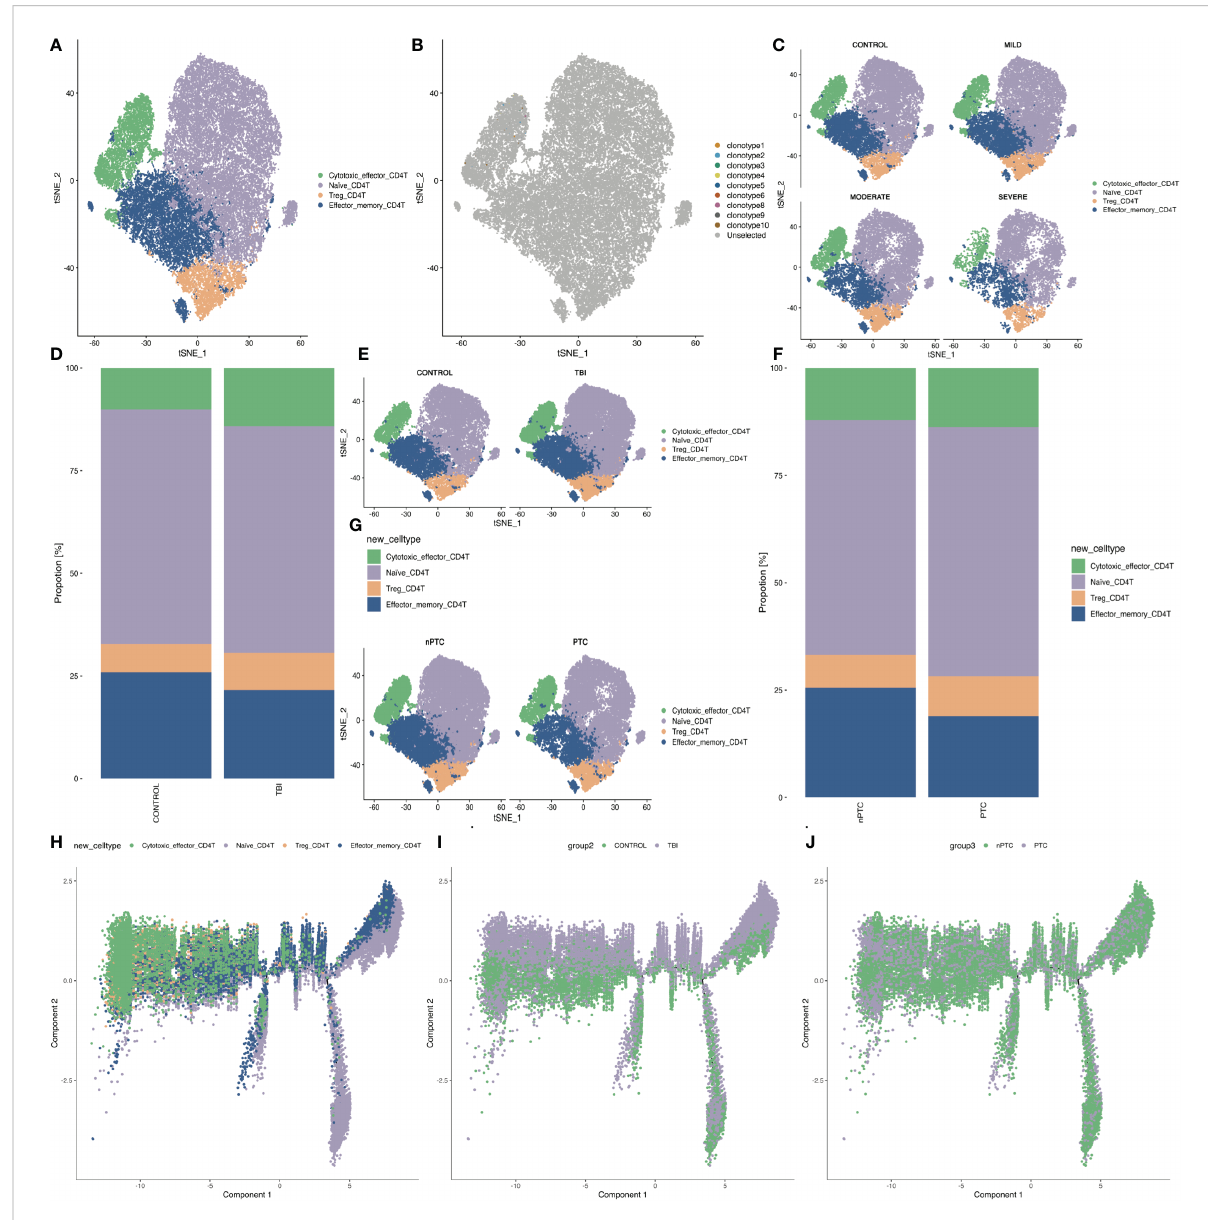
FIGURE 3 The subpopulations of CD4+ T cells of PBMCs in TBI patients. (A) The four clusters of CD4+ cells in t-SNE map. (B) The TCR clone in each CD4 + cell cluster. (C) The t-SNE map shows the different distribution of four clusters in control, mild, moderate, and severe TBI. (D, E) t-SNE map shows the four CD4+ cell subsets between TBI and control and quanti fi cation of the proportion of cells in each group. (F, G) t-SNE map shows the four CD4+ cell subsets between nPTC and PTC groups and quanti fi cation of the proportion of cells in each group. (H – J) Pseudo-time analysis for CD4 subsets between control vs. TBI and nPTC vs. PTC